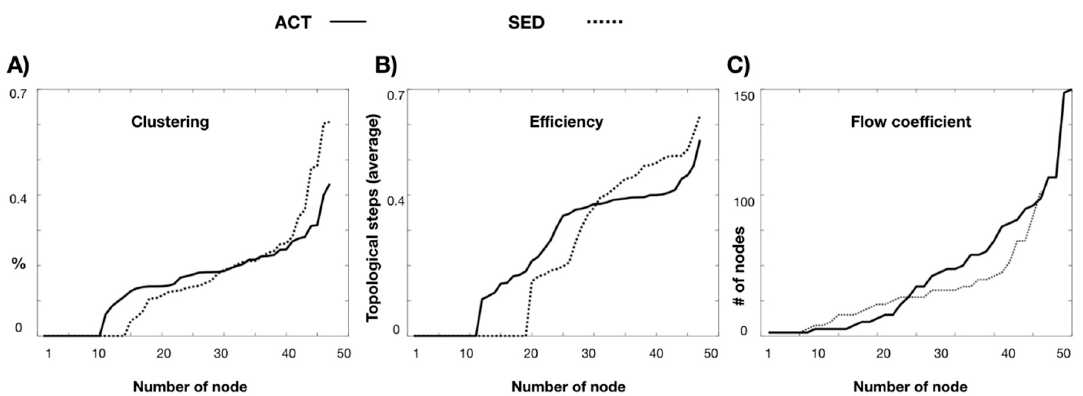
Figure 1. Topological comparison of active (ACT) and sedentary (SED) microbiota networks for clustering ( A ), e ffi ciency ( B ), and flow coe ffi cient ( C ). ACT group is represented with solid line and SED group with dotted line. #